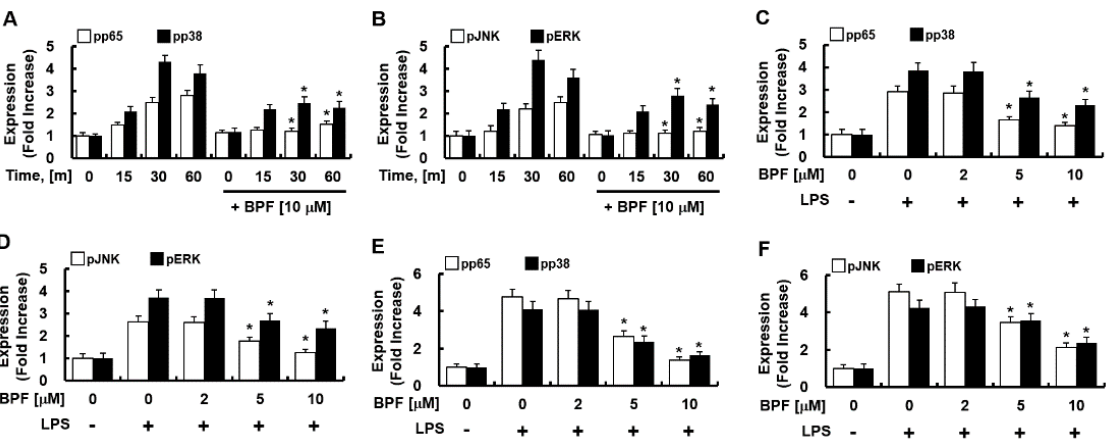
Figure 4. BPF inhibits the phosphorylation of NF- κ B and MAP kinase in LPS-stimulated macro- phages. ( A , B ) HUVECs were pretreated with BPF (10 μ M for 6 h), then LPS (100 ng/mL) was added. Cellular protein was extracted at the indicated times; ( C , D ) HUVECs were pretreated with the in- dicated concentrations of BPF for 6 h, then LPS (100 ng/mL) was added. After 1 h, the cellular protein was extracted. ( E , F ) THP-1-macrophages cells were pretreated with the indicated concentrations of BPF for 6 h, then LPS (100 ng/mL) was added. After 1 h, the cellular protein was extracted ( A – C ) The levels of the indicated proteins were determined using ELISA. All results are shown as the means ± SD of three different experiments with triple samples. * p < 0.5 compared to LPS only. 2.4. BPF Reduces Cytokine Production, Pulmonary Damage, and Mortality in LPS-Induced Mouse Septic Shock Model We next verified whether these in vitro results could be replicated in vivo. We used the LPS-induced mouse septic shock model. We found that BPF protected against LPS- induced sepsis. BPF ( i.v. 0.22 or 0.44 mg/kg) treatment significantly reduced the cytokine levels in serum and peritoneal fluid (Figure 5A–E) and lung tissue damage (Figure 5F,G)